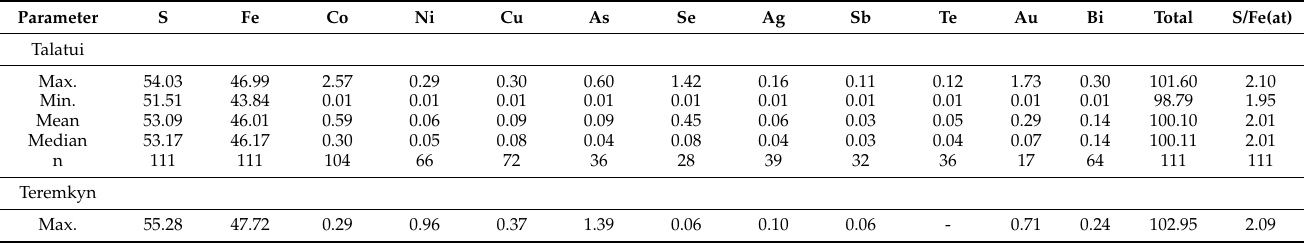
Table 1. Summary of EMPA analyses (wt.%) of pyrite from the gold deposits of the Darasun